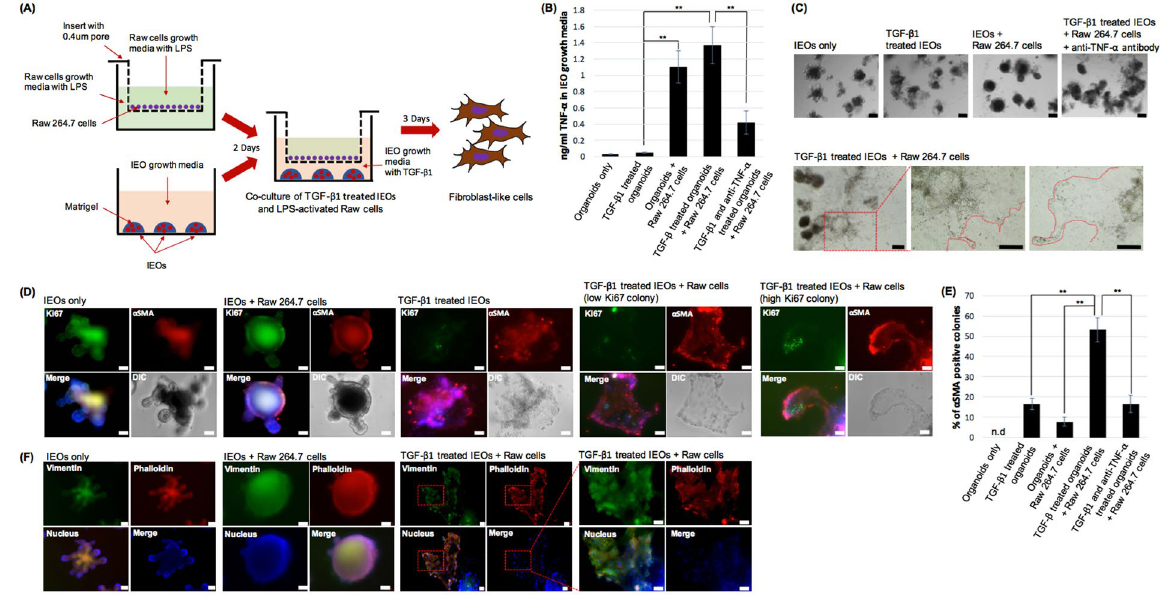
Figure 2. Macrophage released cytokines can synergistically induce mesenchymal phenotypic changes in TGF- β treated IEOs. ( A ) A schematic illustration of the OEMT model with IEOs co-cultured with RAW264.7 cells. ( B ) Quantitation of TNF- α in the culture medium from TGF- β treated IEOs with or without RAW264.7 cells or anti-TNF- α neutralizing antibody. ( C ) Representative images showing the IEOs following TGF- β treatment and RAW 264.7 cells. Bars, 100 μ m. ( D ) The expression of α -SMA and Ki67 was examined in TGF- β 1 treated IEOs with RAW 264.7 cells. Bars, 50 μ m. ( E ) The percentage of α -SMA positive colonies was calculated. Data are presented as the mean ± SEM; n = 4 samples per bar, ** p < 0.01, * p < 0.05. ( F ) The expression